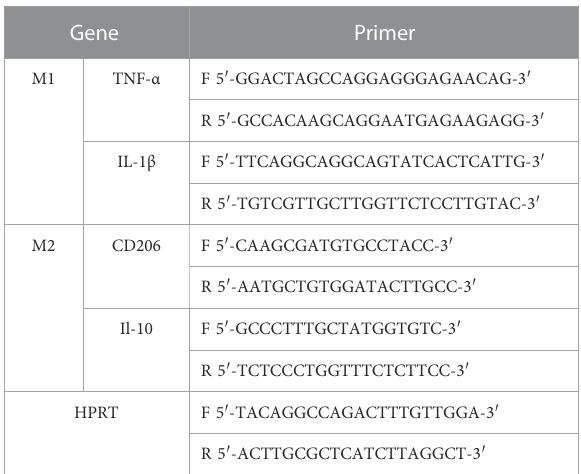
TABLE 1 Primers for quantitative real-time